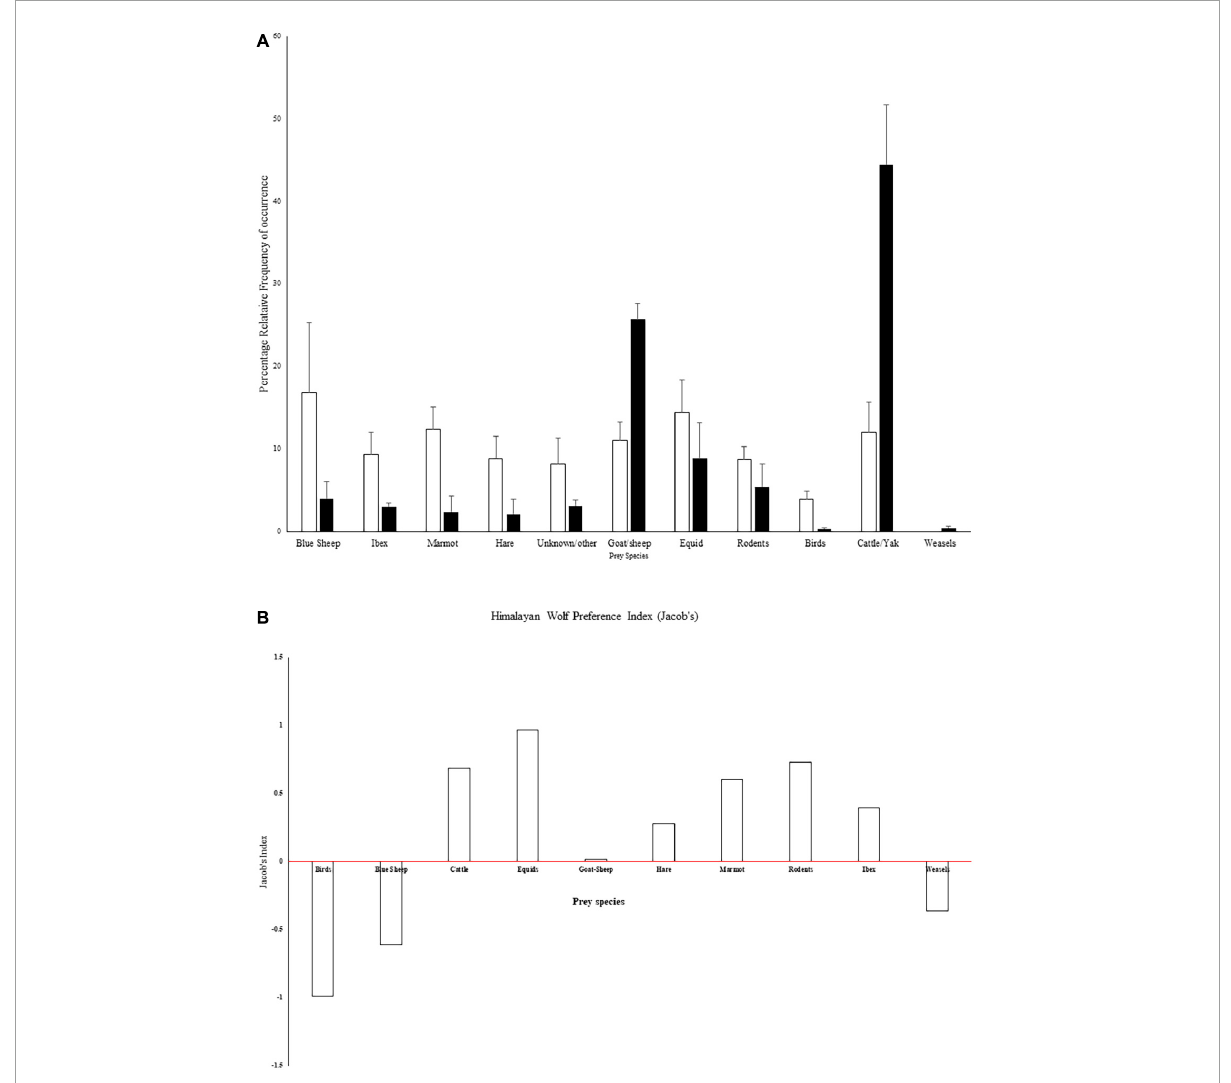
FIGURE2 (A) Percentage relative frequency of occurrence of prey items in wolf scats from the Spiti region (Filled bars) in comparison with wolves from 21 studies across Asia (Lyngdoh et al., 2020) across years (2015–2017, n = 283). Filled/White bars indicate percentage and whiskers indicate ± 1 SE. (B) Jacob’s index for wolf prey preference. Except for Birds, blue sheep and weasels wolves consumed other prey species more than their availability. Preference may change according to